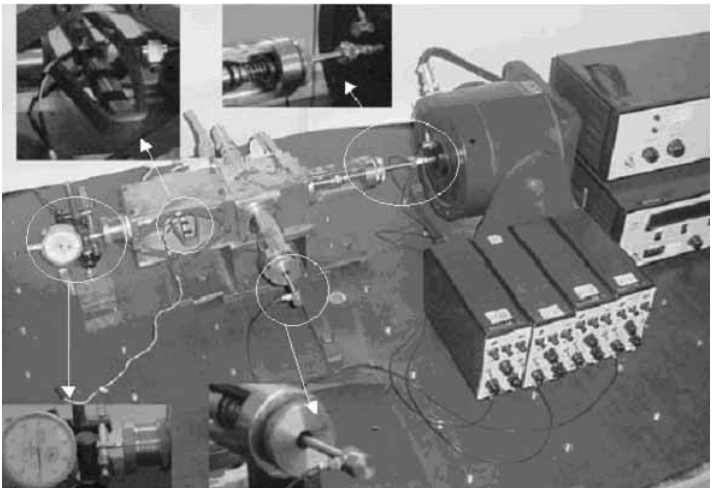
Fig. 8. Experimental set up of the active damper.